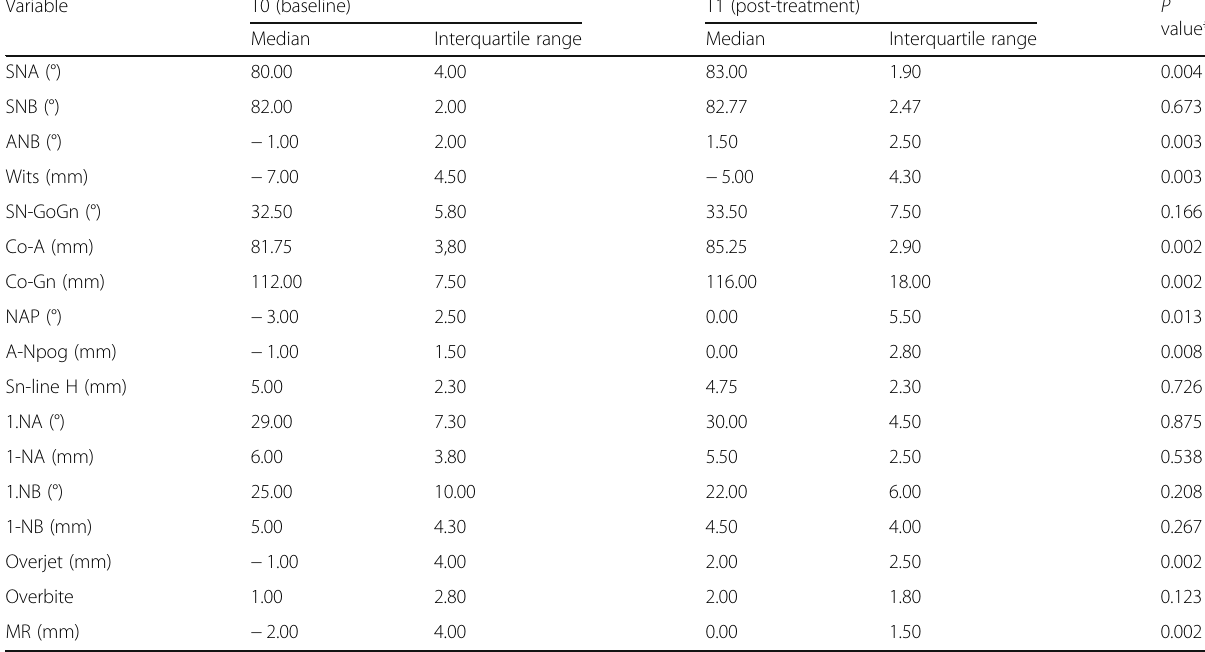
Table 2 Intragroup comparisons (T0 vs. T1) of the facial characteristics for the facemask group Variable